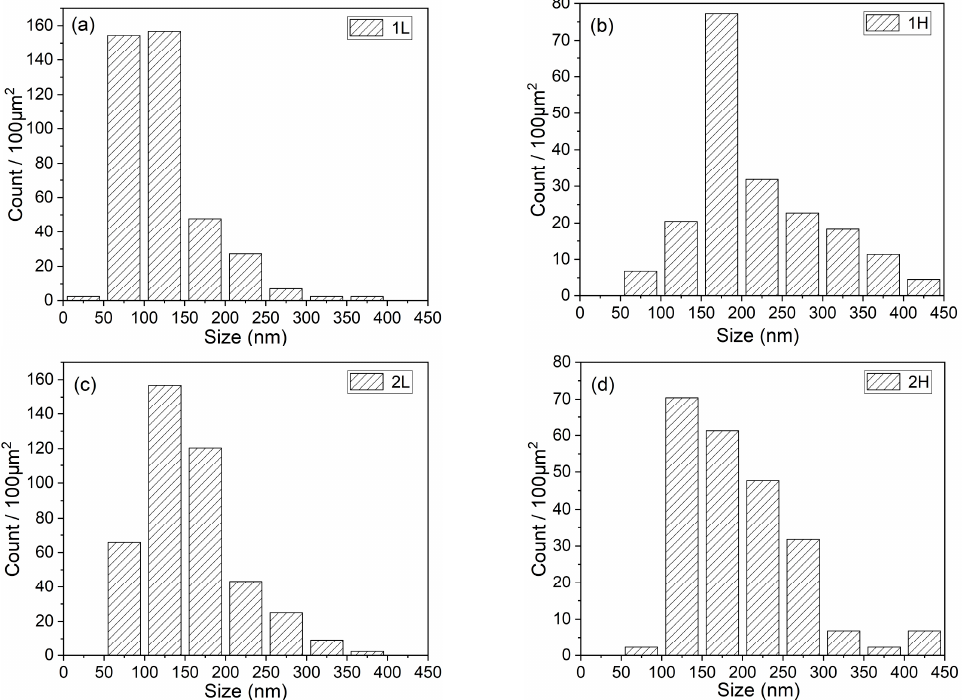
Figure 7. The number density of M 23 C 6 in experimental steels after heat treatment ( a ) 1L (low Si and low temperature), ( b ) 1H (low Si and high temperature), ( c ) 2L (high Si and low temperature), and ( d ) 2H (high Si and high temperature).